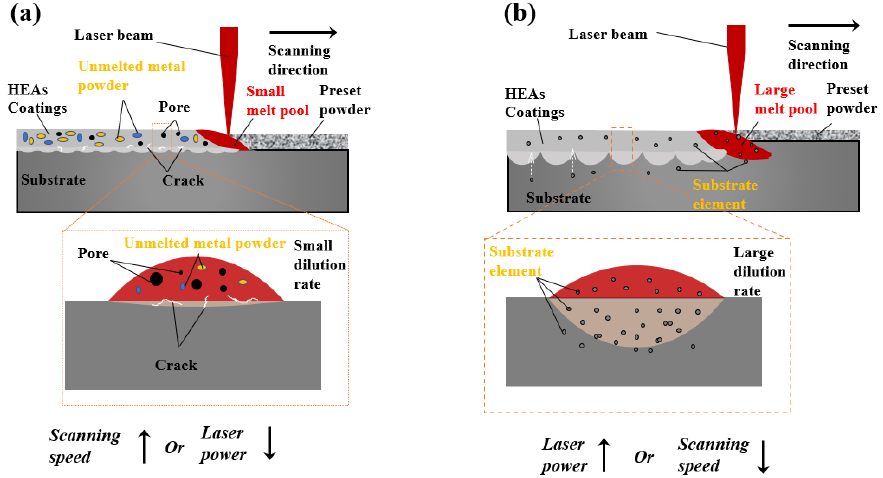
Figure 1. Influence mechanism of laser power and scanning speed on the preparation of HEA coatings: ( a ) laser power is too small or scanning speed is too fast; ( b ) laser power is too large or scanning speed is too slow.